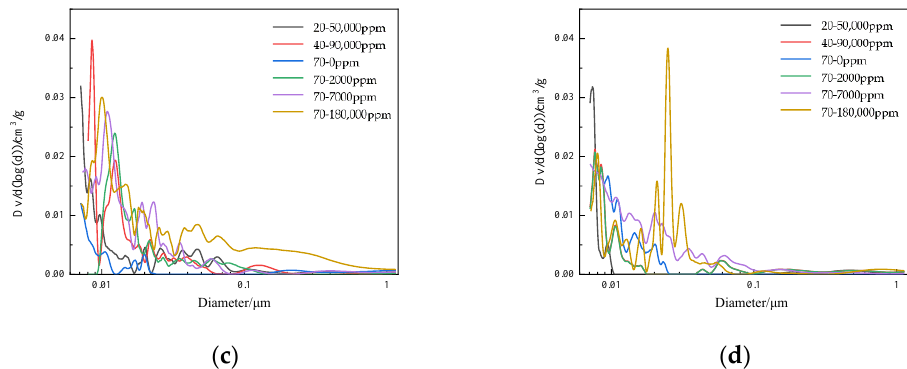
Figure 11. The porosity of the concrete at different ages. ( a ) 0 days; ( b ) 28 days; ( c ) 90d days and ( d ) 180 days.